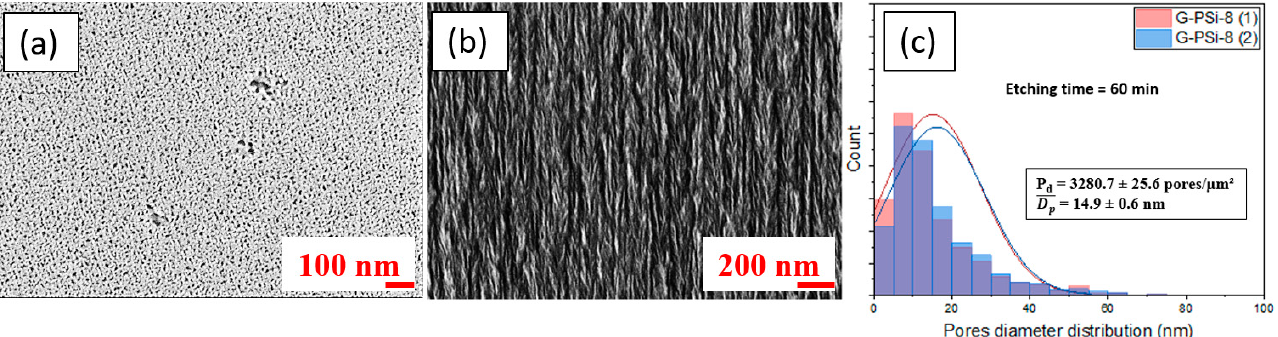
Figure 5. Characterization of G-PSi: ( a ) SEM top surface and ( b ) cross-section with ( c ) pore diameter distribution for G-PSi-8.